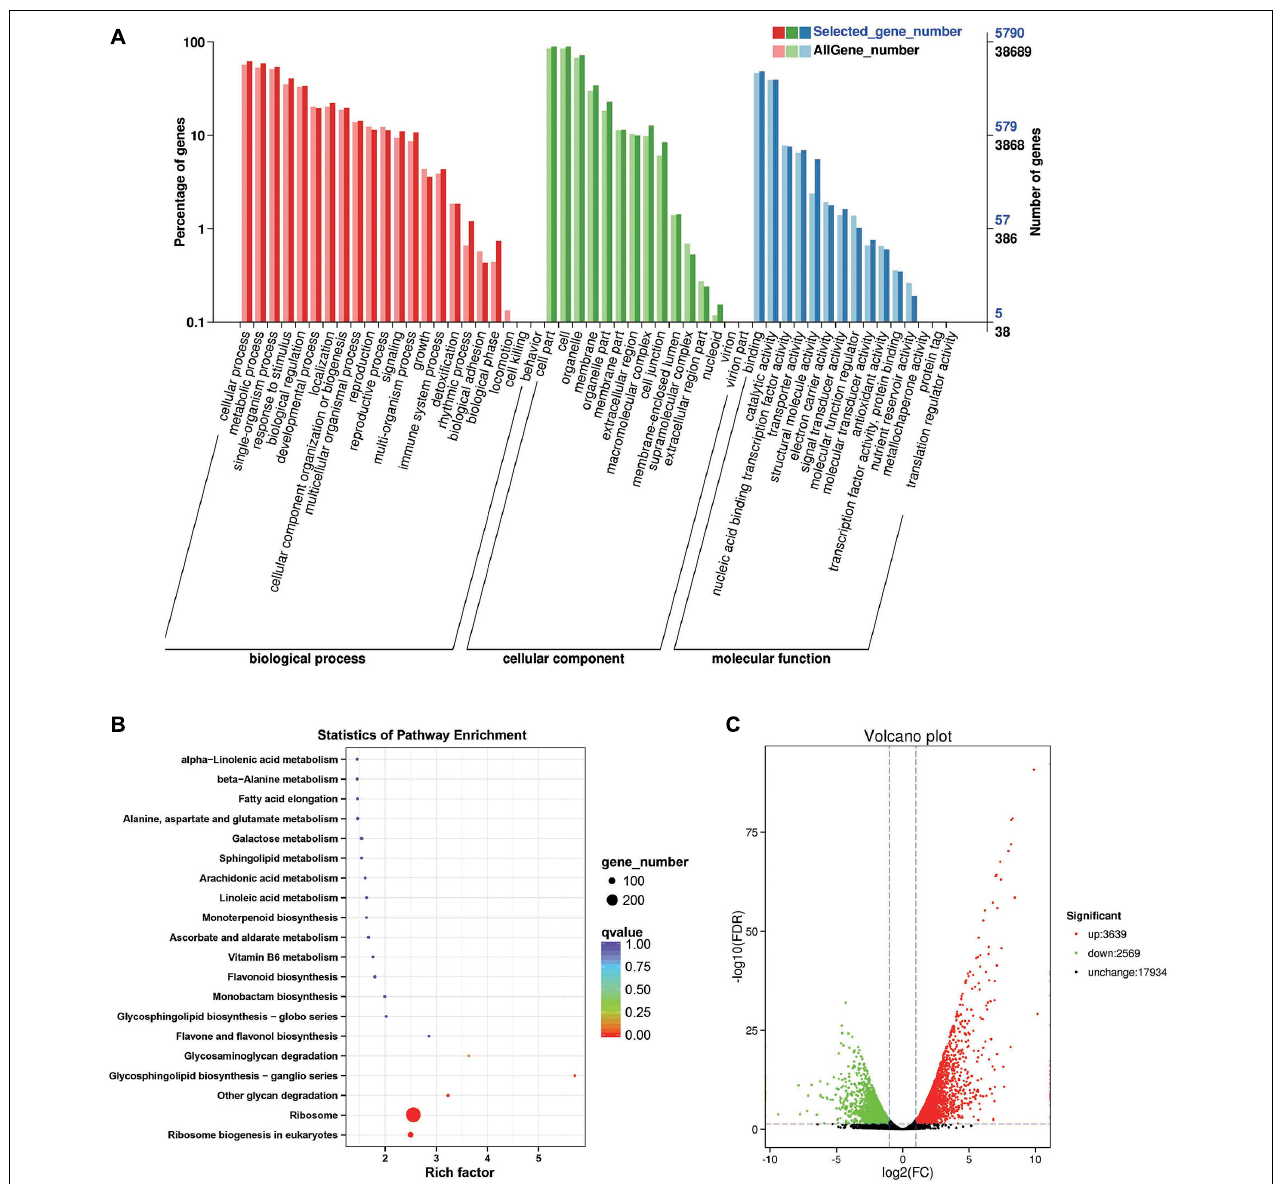
FIGURE 3 | Enrichment analysis of differentially expressed genes between C2 and C1 groups. (A) Gene Ontology (GO) classification statistics of differentially expressed genes. It mainly includes three branches: biological process, cellular component, and molecular function. (B) Kyoto Encyclopedia of Genes and Genomes (KEGG) pathway enrichment statistics of differentially expressed genes. (C) Volcano plot statistics of the number of differentially expressed genes. C1: BcL.1-25 , C2: BcL.1-4 .